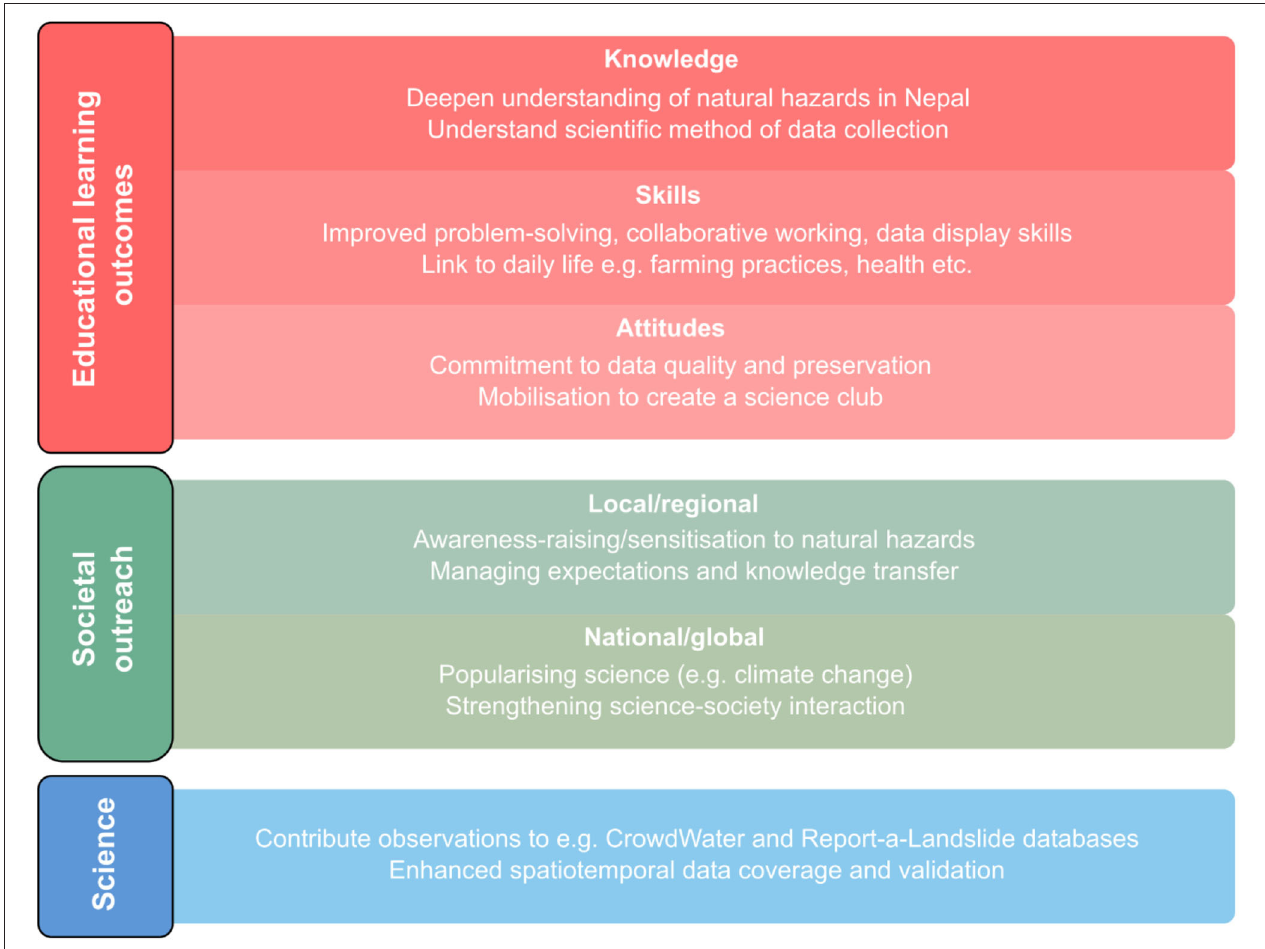
FIGURE 1 | Educational, social/societal, and scientific objectives of the case study, used as a “testbed” for the framework (section Framework Construction).